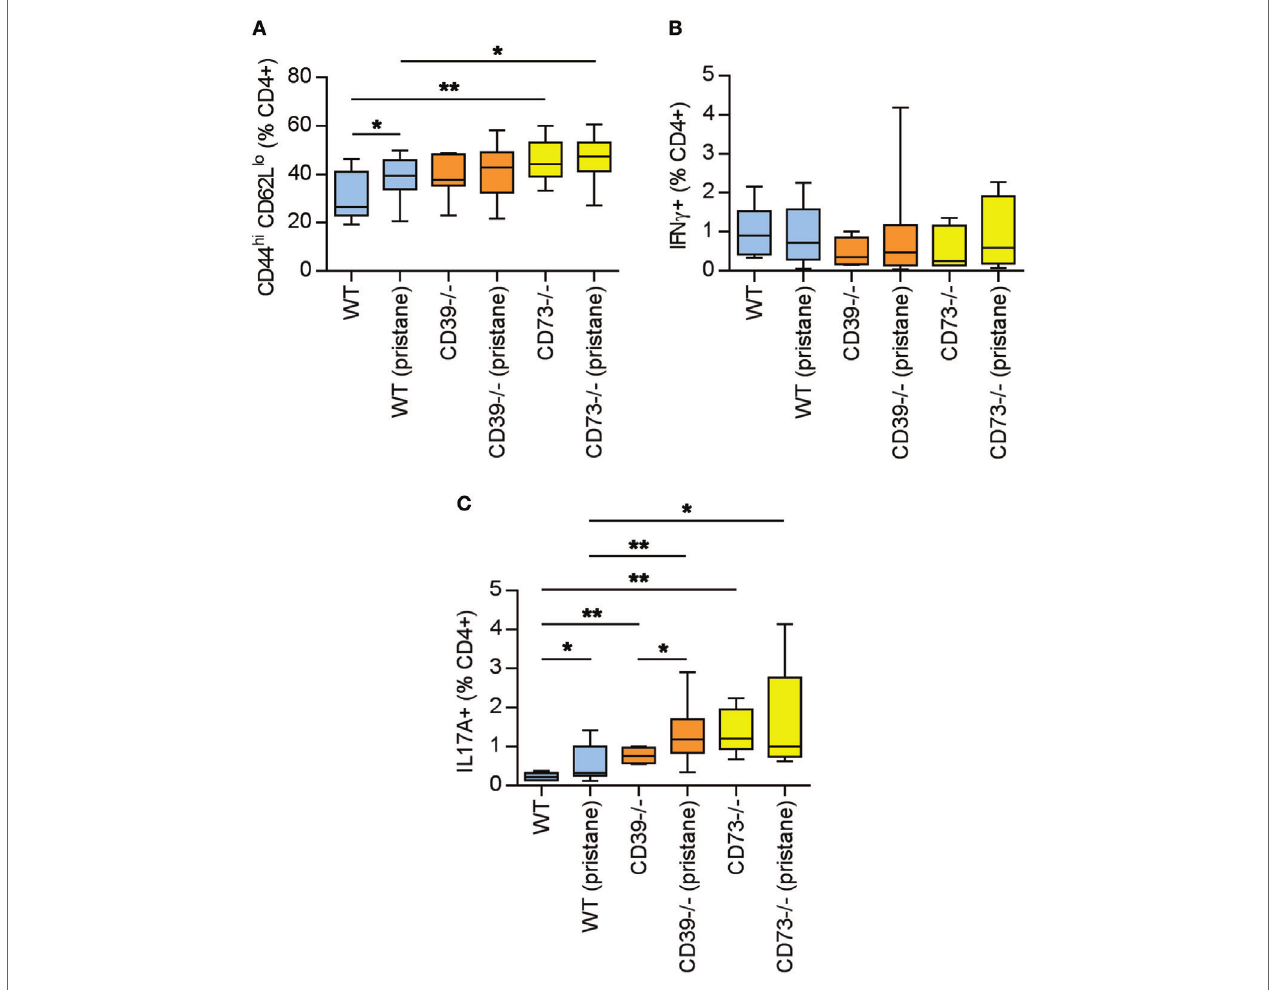
FigUre 4 | Potentiation of T cell activation and T H 17 polarization by ectonucleotidase deficiency. Mice were administered either saline or pristane, as indicated. 36 weeks later, splenocytes were analyzed by flow cytometry. (a) CD44 hi CD62L lo effector/memory T cells, presented as the percentage of CD4 + T cells. (B) Percentage of CD4 + T cells expressing interferon gamma. (c) Percentage of CD4 + T cells expressing interleukin 17A. For panel (a) , n = 10 per control group and 17–19 per pristane group. For panels (B,c) , n = 5 per control group and 8–10 per pristane group; * p < 0.05 and ** p <